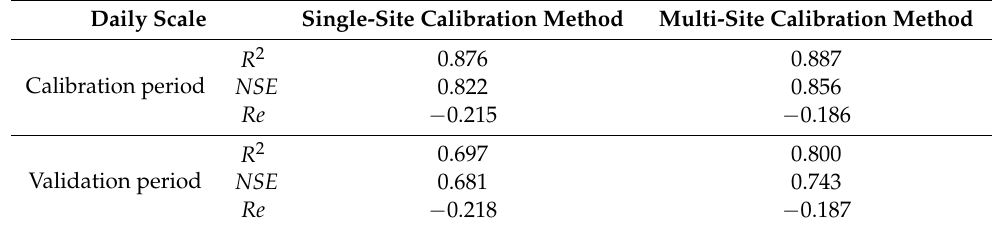
Table 6. Values of evaluation indicators of daily simulated runoff with different calibration methods.